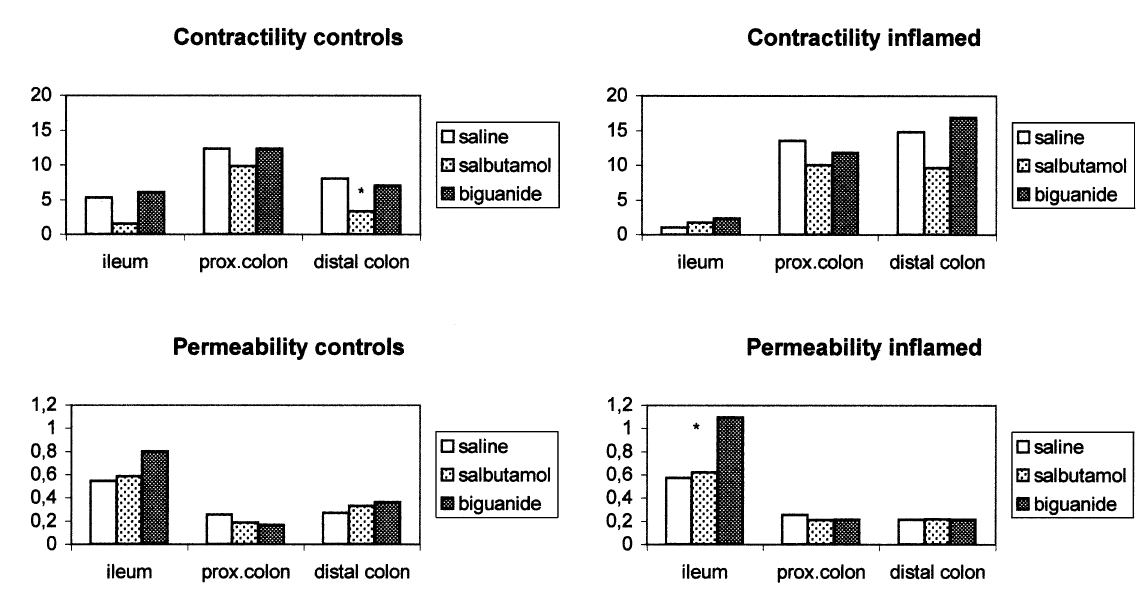
FIG. 1. Mean effects of salbutamol (10 (cid:3) 4 M) and biguanide (10 (cid:3) 6 M) on contractility measured as the number of movements in intestinal segments from the ileum, proximal colon and distal colon in control mice (n (cid:5) / 6; top left panel) and DSS-induced inflammation ( n (cid:5) / 6; top right panel), and on permeability determined by the PEG 4000/mannitol ratio in the same intestinal segments of control mice (bottom left panel) and DSS-induced inflammation (bottom right panel). * p B / 0.05 versus saline.